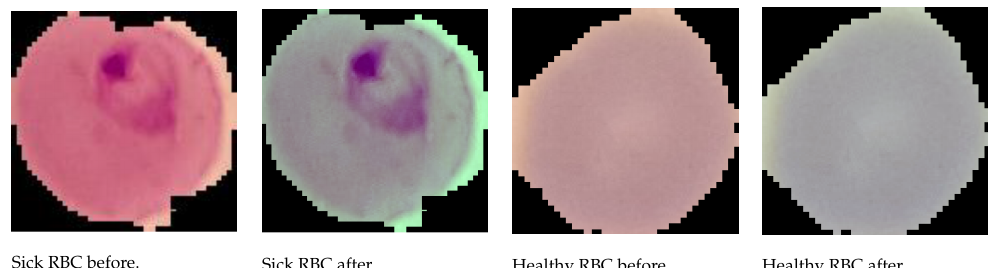
Figure 3. Examples of NIH images, before and after preprocessing step.